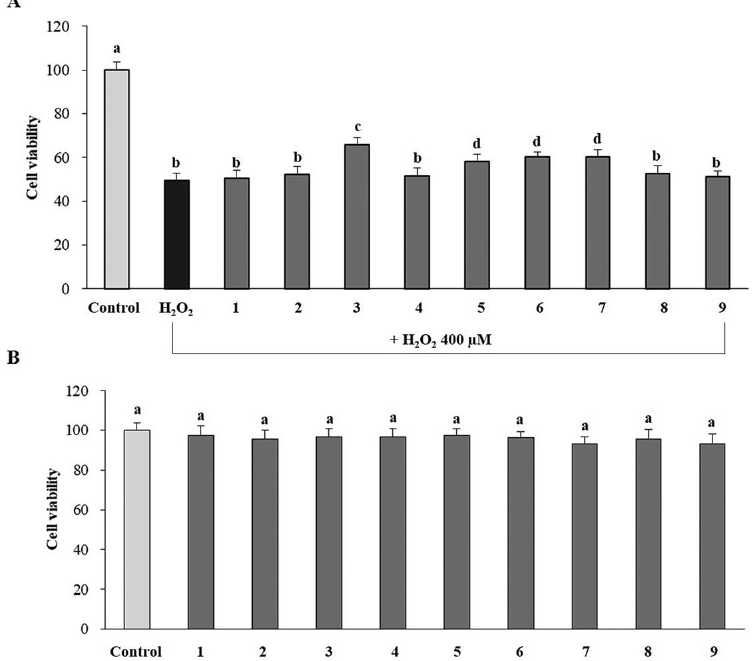
Figure 5. Evaluation of the effect of compounds ( 1 – 9 ) on cell viability in oxidative-stress-induced ARPE-19 cells. ( A ) Cells were pre-treated with compounds ( 1 – 9 ) at 25 µg/mL for 24 h. After incubation, cells were induced with 400 µM H 2 O 2 for 60 min. ( B ) Cells were treated with compounds ( 1 – 9 ) at 25 µg/mL for 24 h. Cell viability was determined using an MTT assay. Results present average cell viability as mean ± SD ( n = 4). Different superscript letters (a – d) indicate significant differences between values in the column ( p < 0.05).